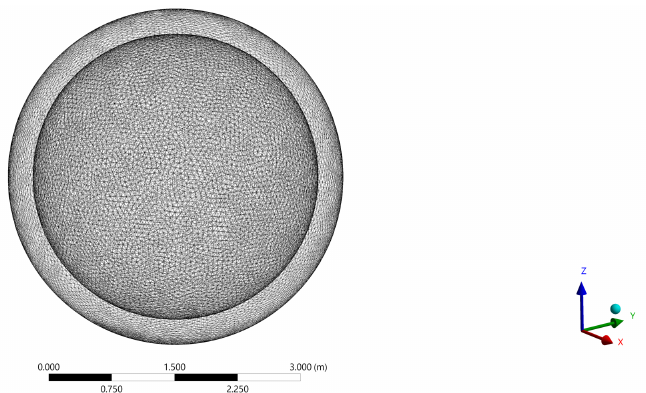
Figure 5. Mesh generation for the solid domain.